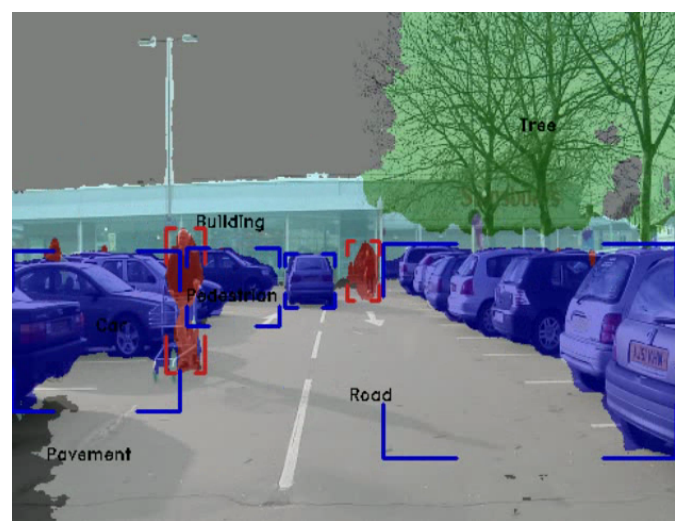
Figure 5. Semantic Segmentation of a typical automotive scene.